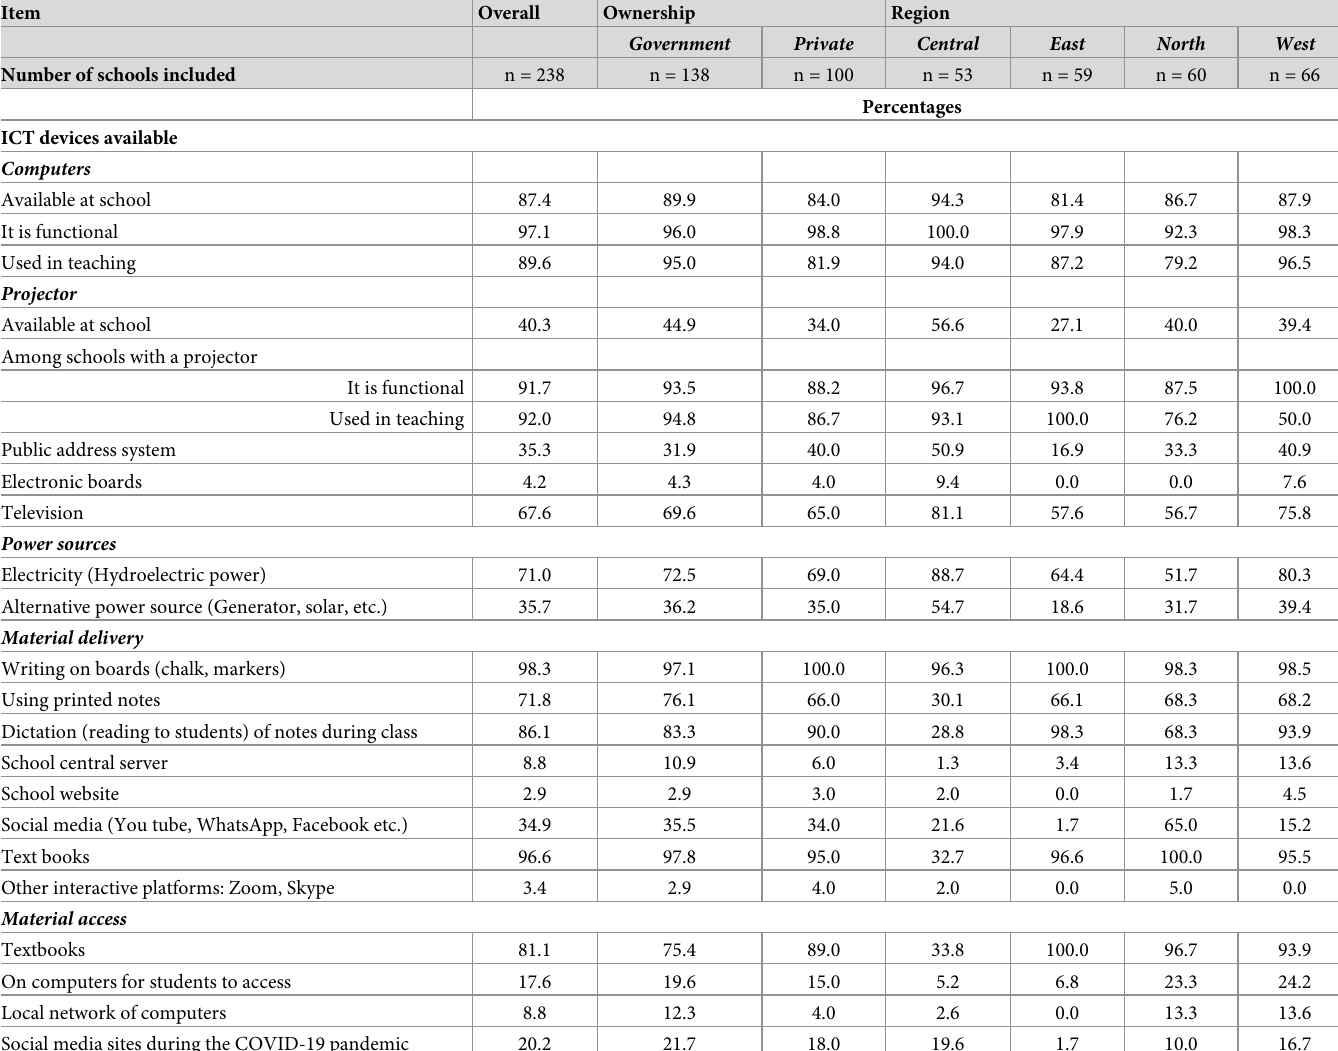
Table 4. ICT in School—Survey findings (numbers and